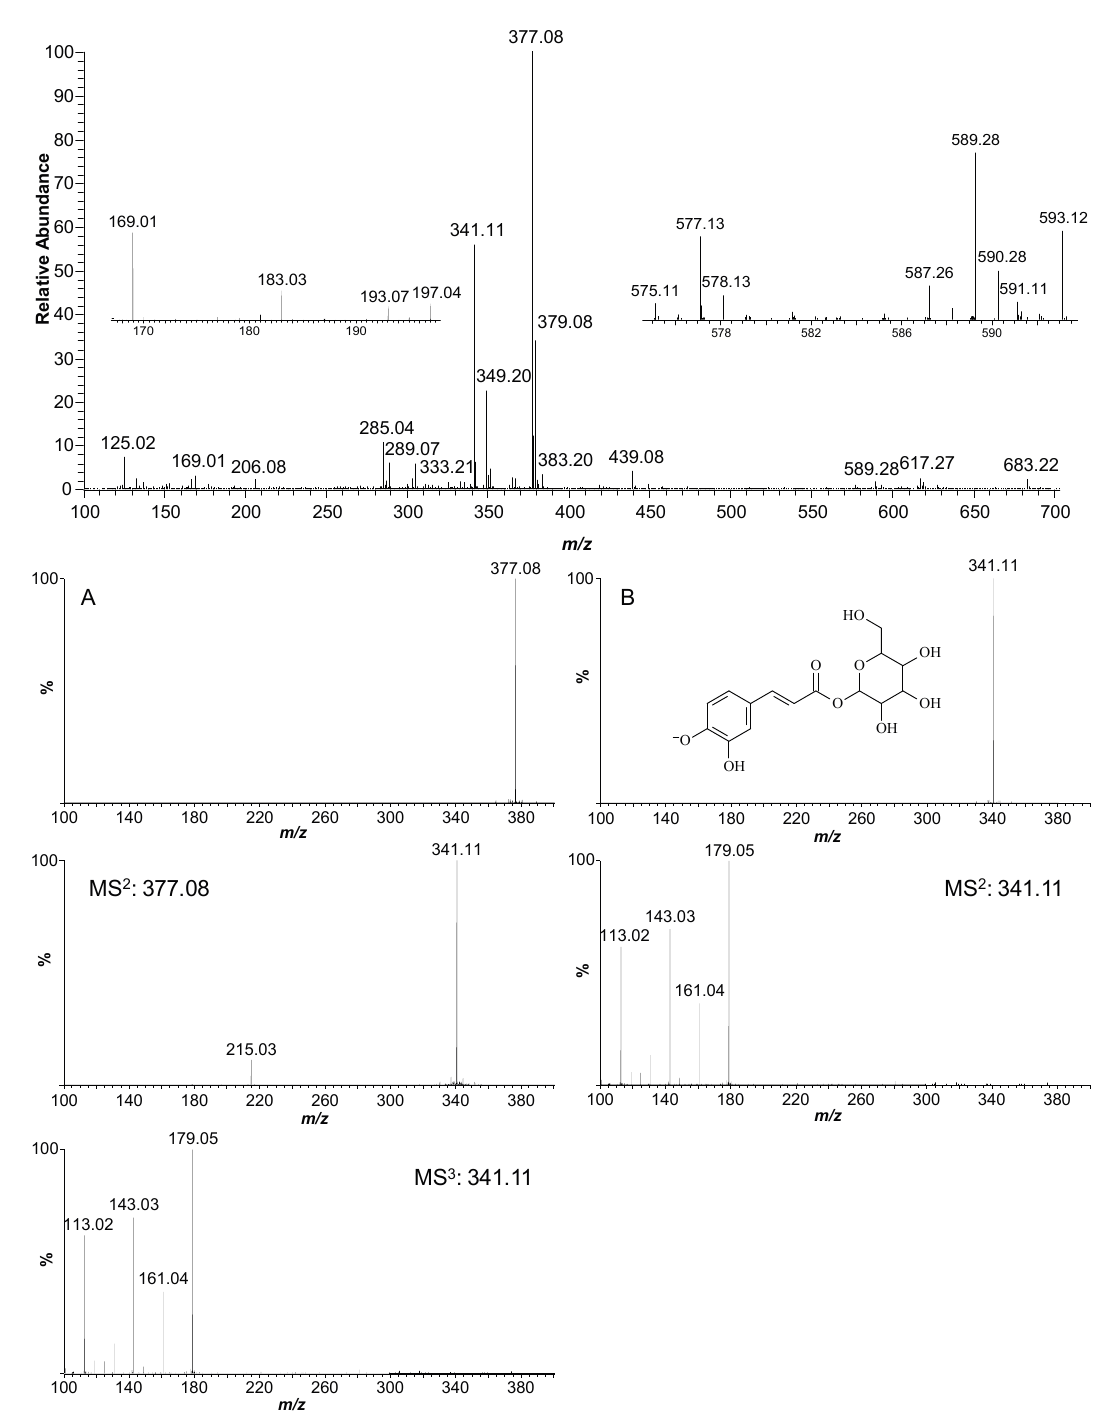
Figure 3. High-resolution fingerprint profile of ethanolic stem bark extract of Mimosa caesalpiniifolia . ( A ) MS n spectra of caffeoyl hexoside derivative ( m/z 377.08 [M − H] − ) and ( B ) MS n spectra of caffeoyl hexoside ( m/z 341.11 [M − H] −